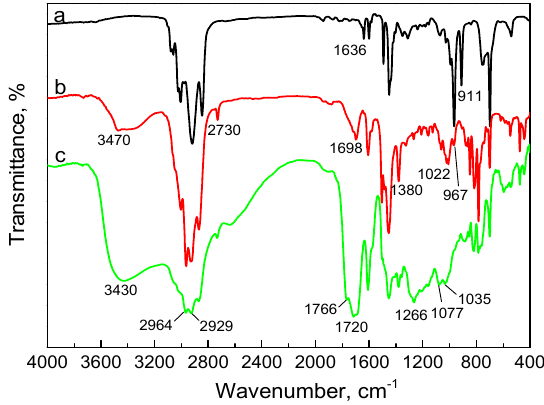
Figure 5. FTIR spectra of ( a ) neat SBS; ( b ) aged SBS exposure at 150 °C for 12 h with an oxygen flowrate of 1 L/min; ( c ) aged SBS exposure at 150 °C for 48 h with an oxygen flowrate of 1 L/min.